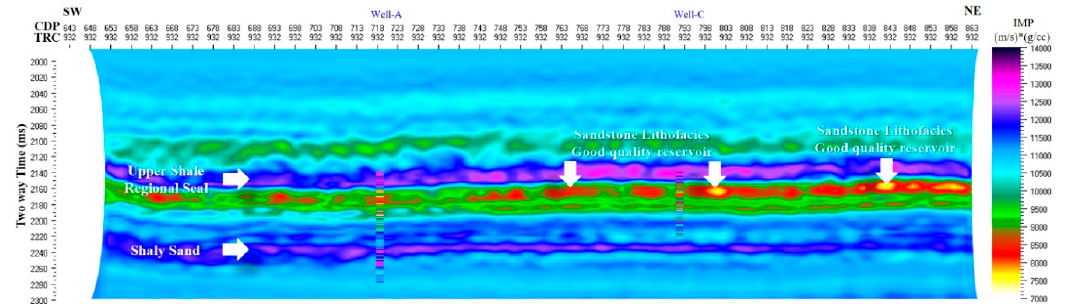
Figure 12. The inverted AI for Xline 932 using SVM seismic inversion. The impedance log of well-A, C, and D are not in good match with the inverted impedance surface.